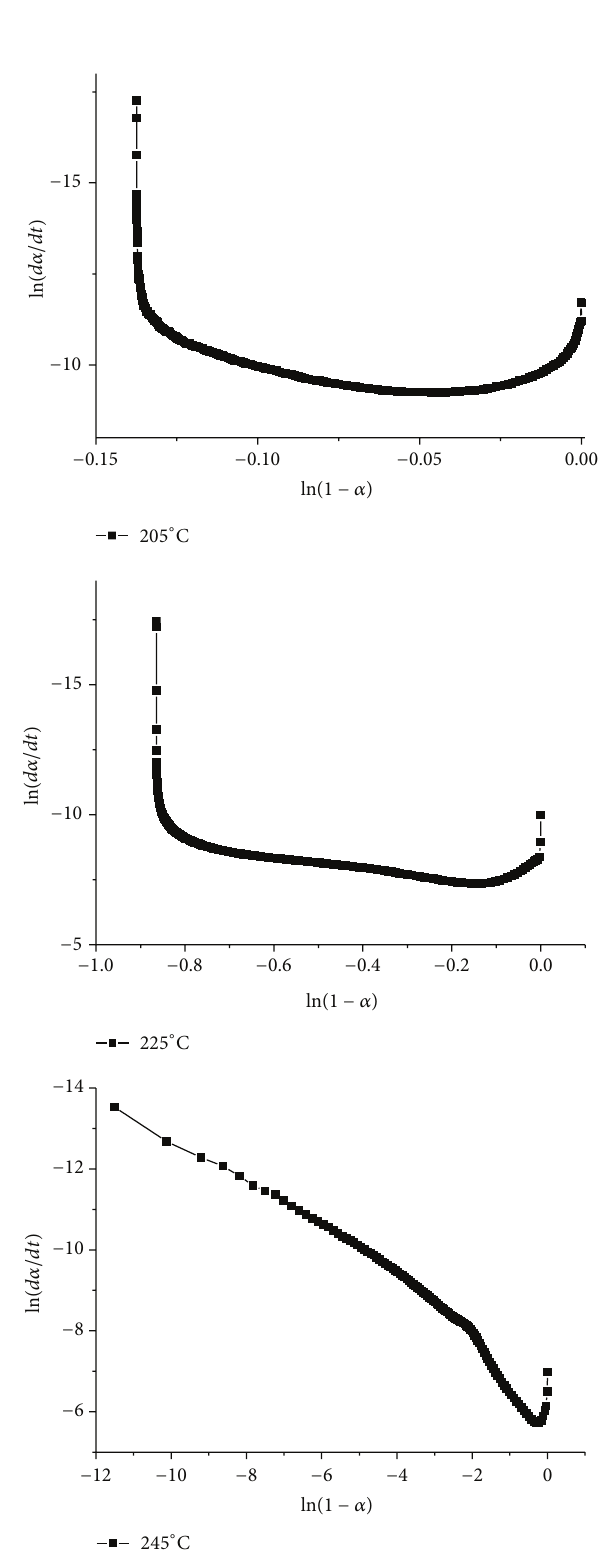
Figure 7: ln (𝑑𝛼/𝑑𝑡) versus ln (1 − 𝛼) curves of F-51/BZ hybrid